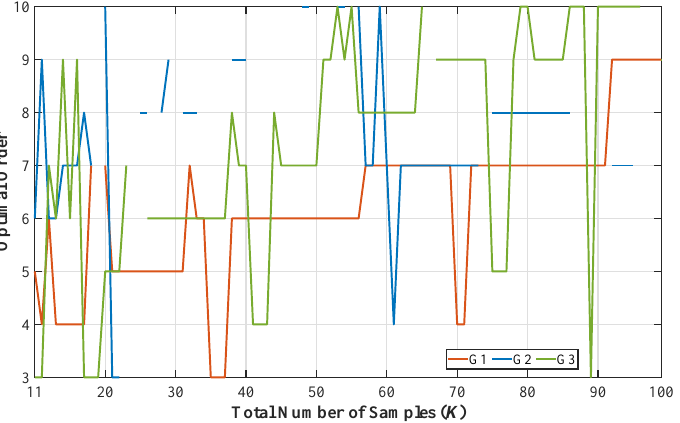
Figure 5. Impact of window length on inertia estimates of SGs G1, G2, and G3. ( a ) Method #1, polynomial method/variable order, ( b ) Method #2, polynomial method/fifth order, ( c ) Method #3, transfer function method and ( d ) Method #4, impulse method. Missing samples for specific K values denote that the examined methods failed to provide inertia estimates.